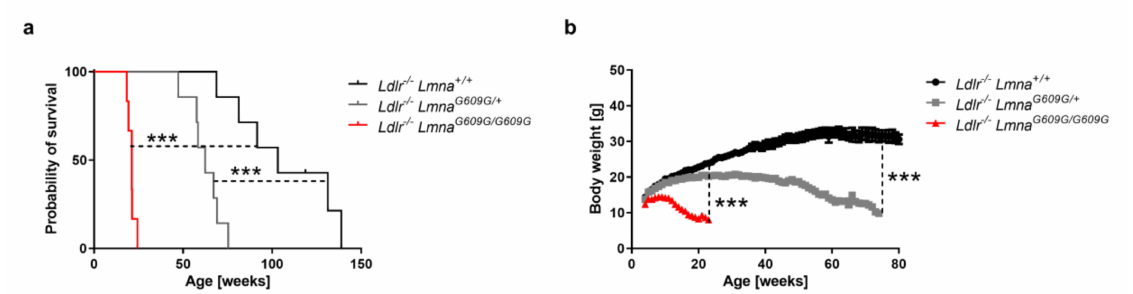
Figure A1. Shortened survival and reduced body weight in female Ldlr − / − Lmna G609G / G609G and Ldlr − / − Lmna G609G /+ mice. ( a ) Kaplan–Meier survival curves of Ldlr − / − Lmna +/+ mice ( n = 7), Ldlr − / − Lmna G609G /+ mice ( n = 7), and Ldlr − / − Lmna G609G / G609G mice ( n = 6) fed normal chow. ( b ) Body weight curves for Ldlr − / − Lmna +/+ mice ( n = 7), Ldlr − / − Lmna G609G /+ mice ( n = 7), and Ldlr − / − Lmna G609G / G609G mice ( n = 6) fed normal chow. Body weight is shown until death for Ldlr − / − Lmna G609G /+ and Ldlr − / − Lmna G609G / G609G mice, and until 80 weeks of age for Ldlr − / − Lmna +/+ mice. Data are presented as mean ± SEM in ( b ). Statistical analysis was performed by log-rank test in ( a ) and by mixed e ff ects model with the Geisser–Greenhouse correction in ( b ). ***, p <